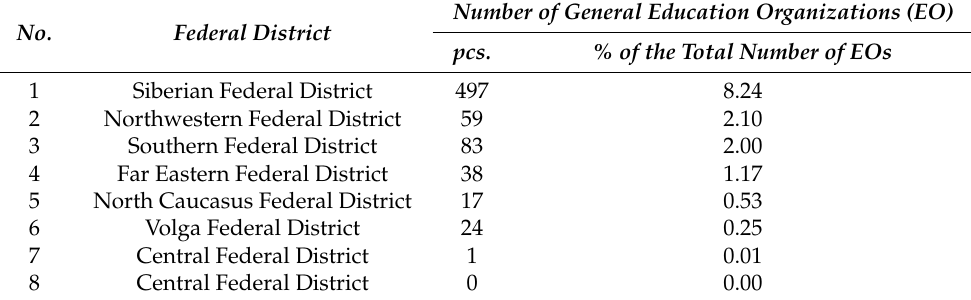
Table 5. The number of general education institutions in federal districts of the Russian Federation using information resources for the automated report